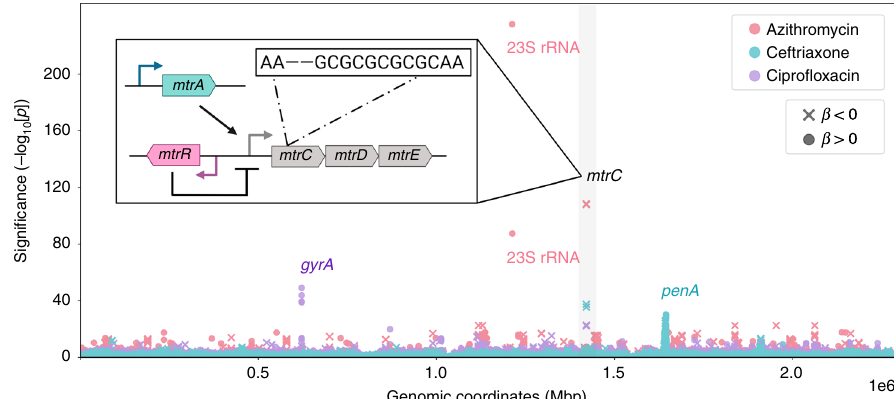
Fig. 2 GWAS identi fi es a variant mapping to mtrC associated with increased susceptibility. The Manhattan plot shows negative log 10 -transformed p -values (calculated using likelihood-ratio tests in the GWAS) for the association of unitigs with MICs to azithromycin (pink, n = 4505), ceftriaxone (blue, n = 4497), and cipro fl oxacin (purple, n = 4135). The sign of the GWAS regression coef fi cient β (with positive indicating an association with increased resistance and negative indicating an association with increased susceptibility) is indicated by an X for β < 0 and a dot for β > 0. Labels indicate known in fl uential resistance determinants, and the mtrC variant associated with increased susceptibility was highlighted in gray. A full list of the annotated signi fi cant unitigs for each antibiotic can be found in Supplementary Data 2. Inset: schematic of the mtr genetic regulon including structural genes mtrCDE , the activator mtrA , and the repressor mtrR . The approximate genomic location within mtrC and speci fi c nucleotide change of the mtrC GWAS variant relative to the gonococcal NCCP11945 reference genome (i.e., a two base pair deletion in a ‘ GC ’ dinucleotide repeat) is